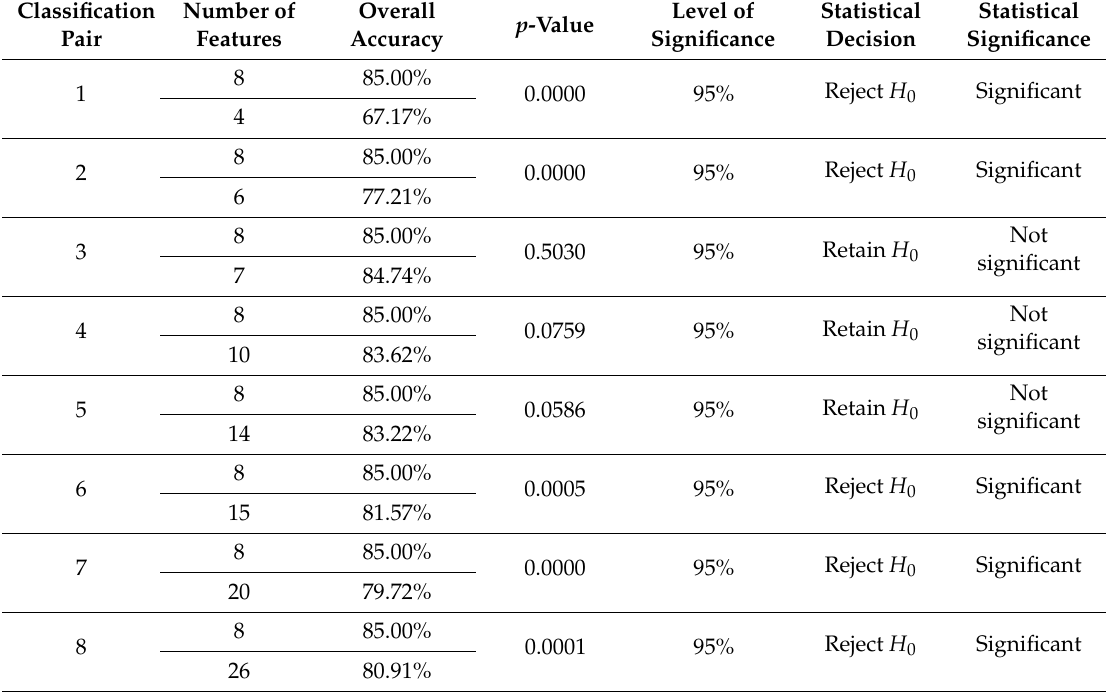
Table 8. The statistical significance of several pairs of classification accuracy estimates based on the McNemar test with reference to the highest classification accuracy (eight